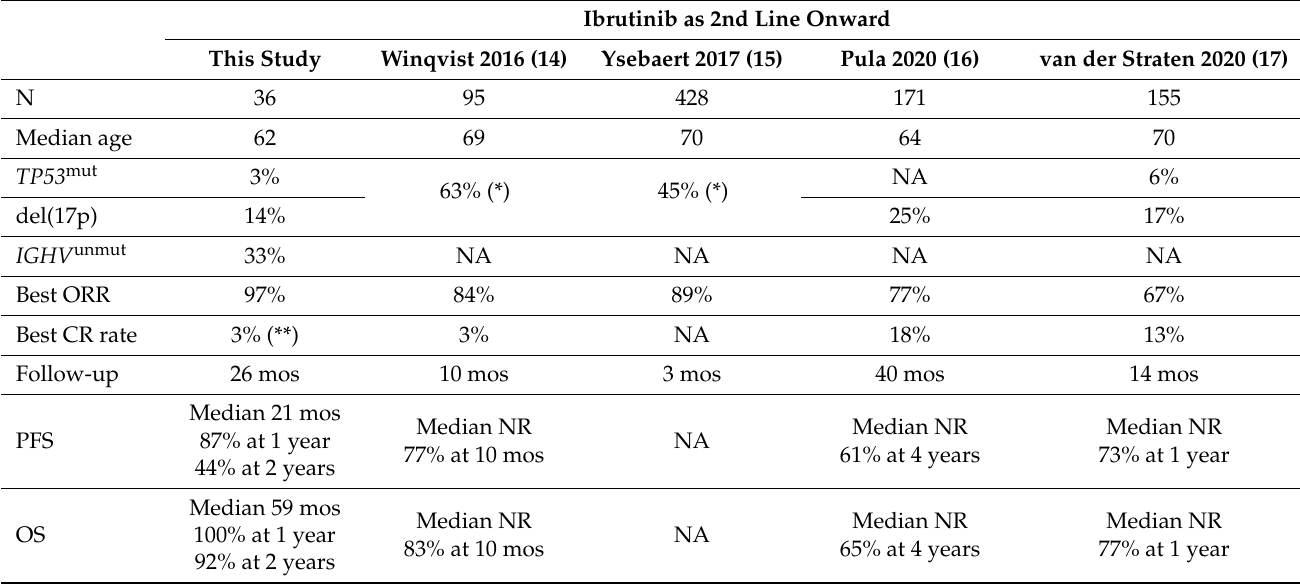
Table 4. Comparisons with previously published real-life experience in patients with relapsed and refractory CLL treated with ibrutinib.